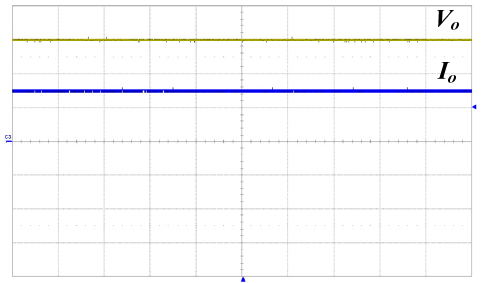
Figure 11. Measured output voltage V o (20 V/div) and current I o (0.2 A/div); time scale: 2 ms/div.